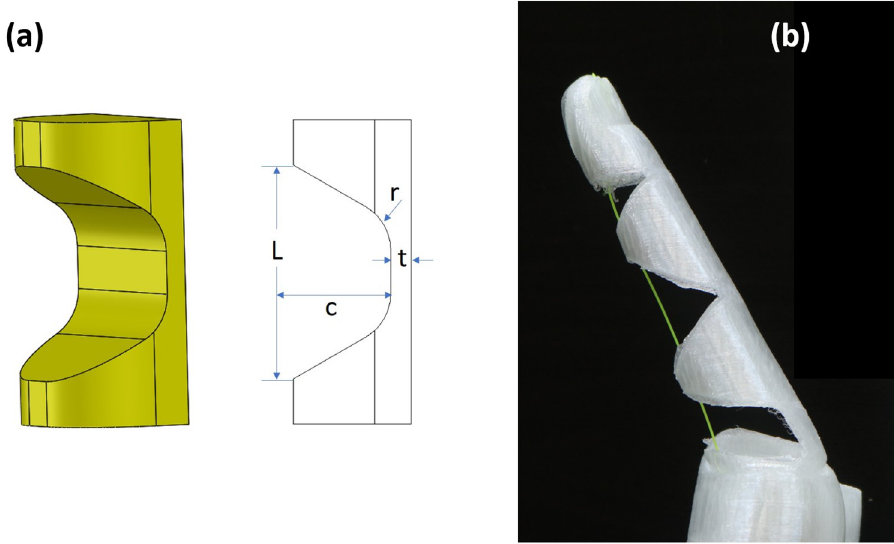
Fig 1. A soft monolithic finger with flexure joints: (a) Corner-filleted flexure joint and design parameters; (b) Finger with three corner-filleted flexure joints (one actuation cable is threaded through the 3 flexure joints).